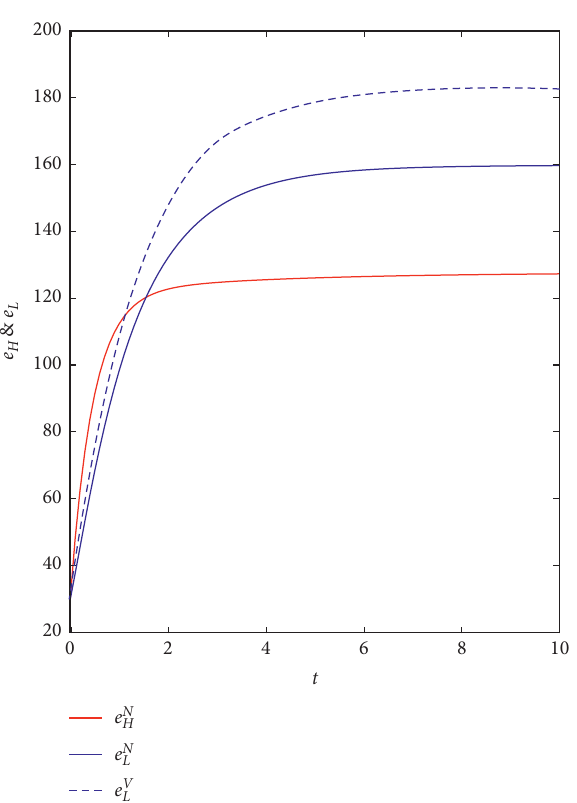
Figure 2: Comparison of the trajectories of the free-riding manufacturer and the green